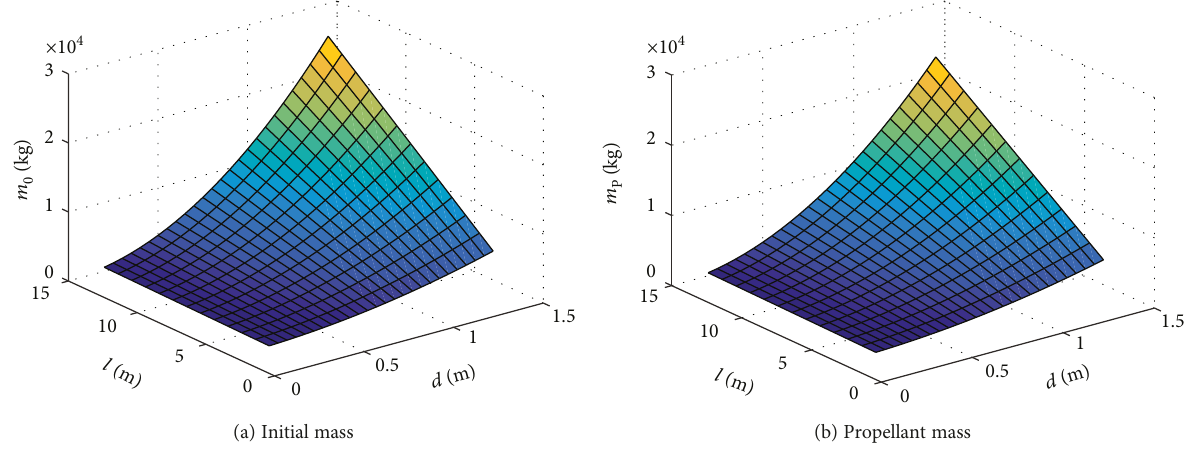
Figure 3: Example of scaled m